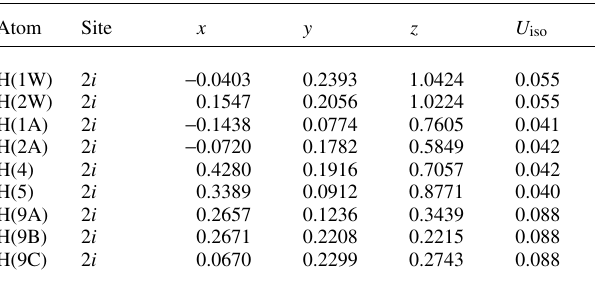
Table 2. Atomic coordinates and displacement parameters (in Å 2 )